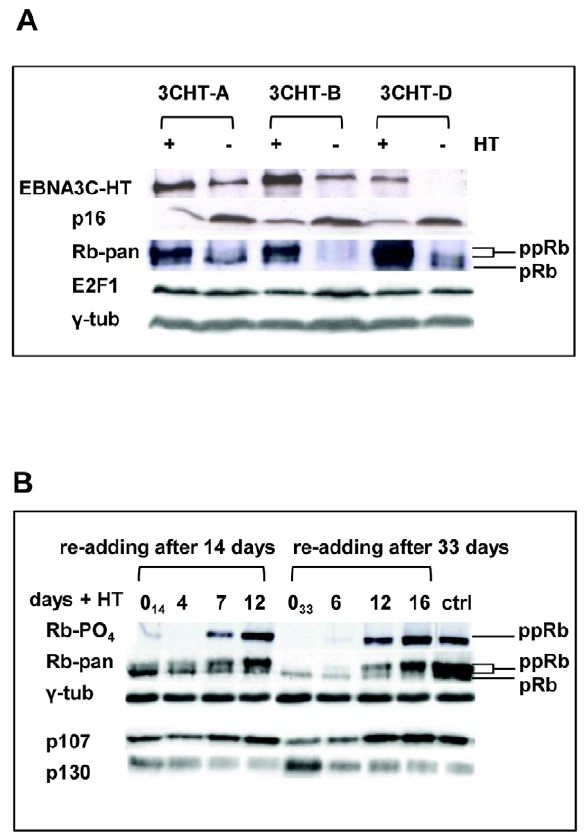
Figure 4. Inactivation of EBNA3C and accumulation of p16 INK4A leads to de-phosphorylation of Rb, reduced expression of p107 and an increase in p130; activation of EBNA3C reverses these processes. ( A ) Western blot analyses of three LCL 3CHT lines performed on whole cell lysates from cells cultured with HT ( + ) without HT for 26 days ( 2 ). As the amount of EBNA3C protein reduces (and is inactivated) and p16 INK4A accumulates, so hyperphosphorylated Rb (ppRb) protein disappears and only hypophosphorylated Rb (pRb) is detected. The levels of E2F1 and c -tubulin ( c -tub) remain unchanged irrespective of the culture conditions. ( B ) Western blot analysis of extracts from cells after re-addition of HT to cultures starved of HT for either 14 or 33 days (0 14 and 0 33 respectively). A pan-specific anti-Rb MAb and phospho-specific MAb (Ser 807–811) both show an increase in hyperphosphorylated Rb (ppRb) after HT was added. After 12–16 days the degree of phosphorylation is equivalent to that in the proliferating control LCL 3CHT population (ctrl). As Rb becomes phosphorylated, expression of p107 increases and expression of p130 decreases. The level of c -tubulin ( c -tub) did not alter throughout the